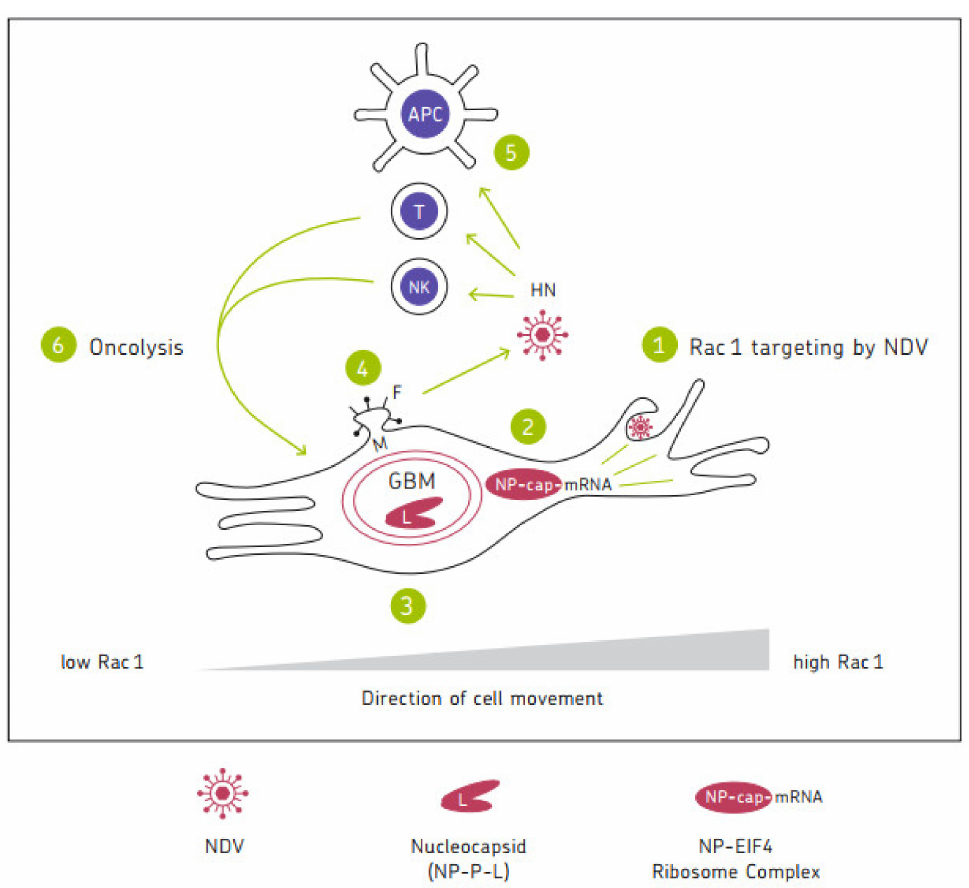
Figure 1. Schematic illustration of mechanisms of anti-tumor activity of NDV, exemplified with a migratory and invasive glioblastoma (GBM) cell. 1. Macropinocytosis/endocytosis of NDV targeting Rac1, which plays a cardinal role in oncogenic alterations and in development of drug resistance. The direction of cell movement is accompanied by an increase in Rac1 expression from the trailing edge (left) to the leading edge at the lamellipodia (right). 2. Targeting the cap-dependent translational machinery, viral mRNA to protein translation in the cytosol and later in the double- membraned autophagosome. This is achieved through the MNK1/2-eIF4E axis. 3. Tumor-selective virus replication in autophagosomes. The clam shaped symbol stands for the helical nucleocapsid structure composed of L, P, and NP proteins. 4. Virus progeny encapsulation, budding, and virus release mediated via M, HN, and F. 5. Antiviral response of healthy normal cells, including immune cells (APC; T, NK) initiated through recognition of HN by NKp46 and other PAMPs by TLRs and RLRs leading to IFN-I secretion and to DC1 and Th1 polarized adaptive immunity responses. 6. NDV- induced tumor cell death responses (oncolysis). These involve extrinsic (immune-mediated) and intrinsic cell death signaling pathways. ICD-derived components feed into APCs which present TAAs to T cells. Several rounds of such cycles (1–6) drive oncolytic effects and lead to immunological memory and systemic antitumor immunity. Figure taken with permission from